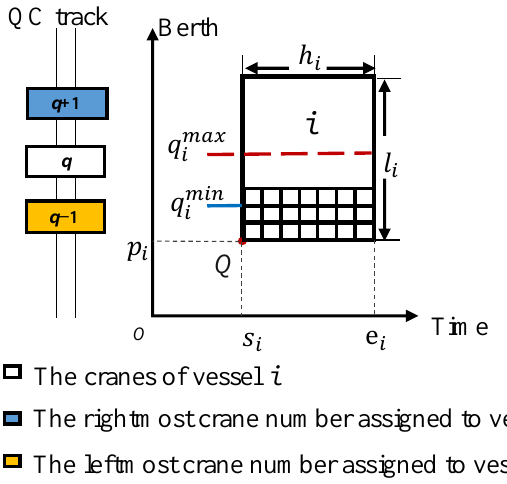
Figure 1. Diagram of the BACASP.